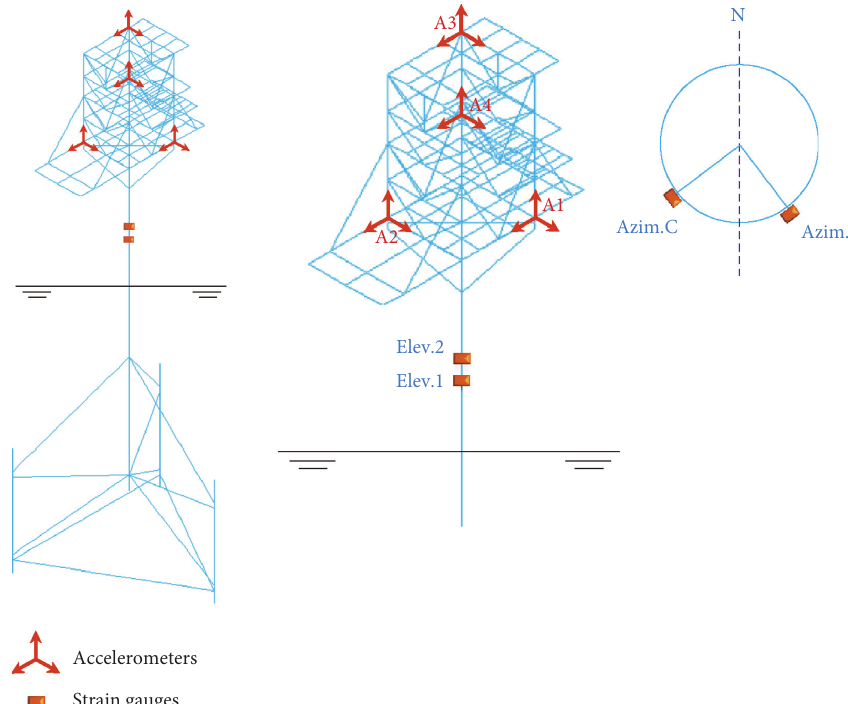
Figure 3: Position of sensors.